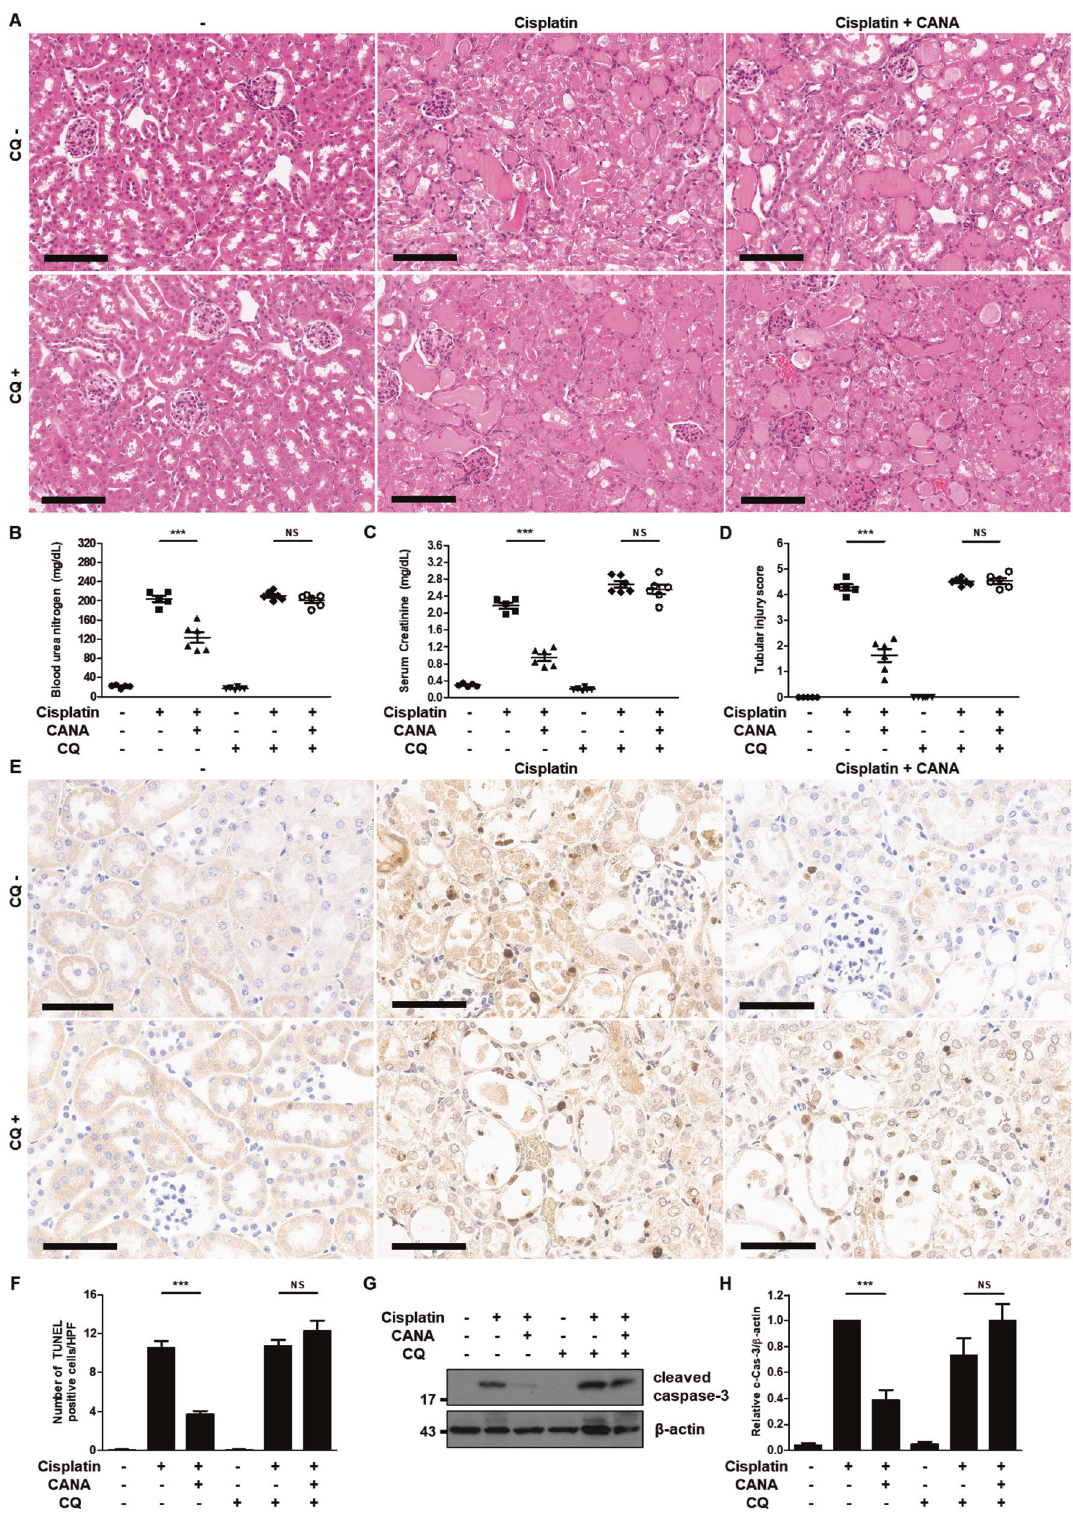
fore, we conducted animal experiments using the mouse model of cisplatin-induced AKI. In animal experiments, canagli fl ozin atte- nuated the cisplatin-induced tubular damage assessed by histopathology and immunoblot analysis of kidney